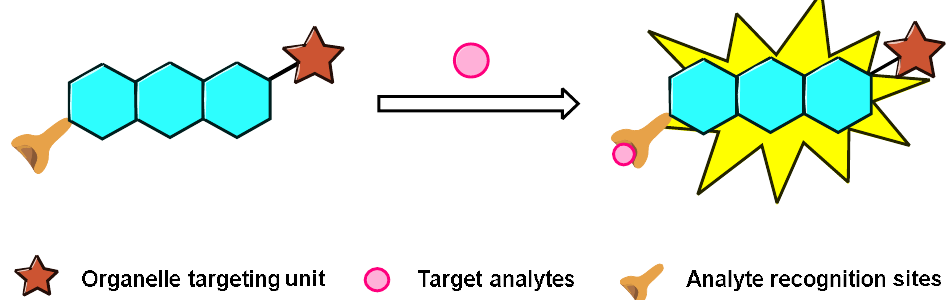
Figure 1. Schematic representation of the chemical molecular labelling method.